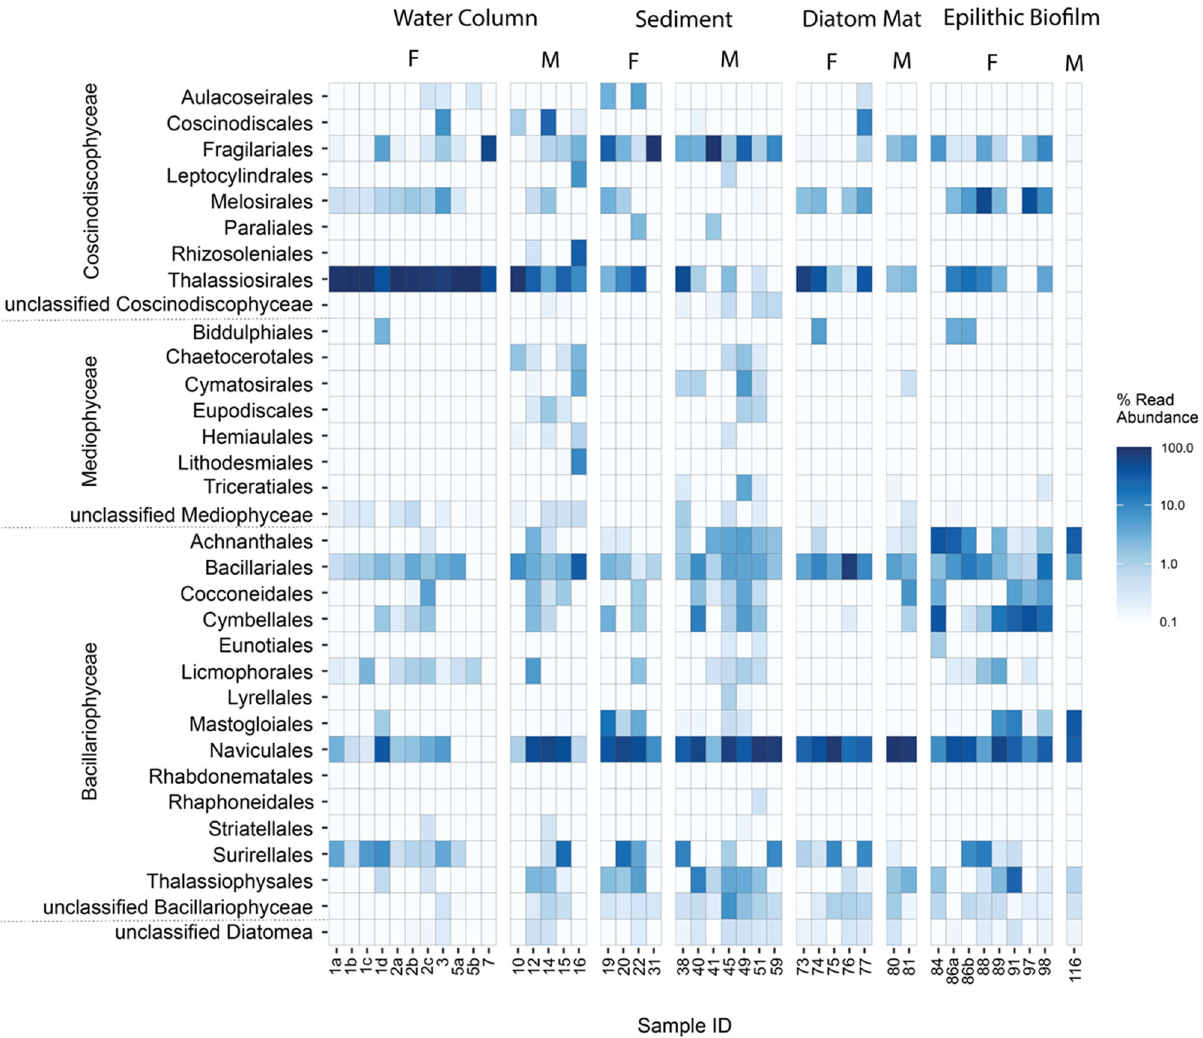
Fig. 6 Diatom community analysis. Heatmap of relative 18S rRNA gene sequence abundance at the level of diatom classes and orders for freshwater (F) and marine (M) water column, sediment, diatom mat, and epilithic bio fi lm samples. Relative sequence abundance scales from white (<0.15%) to dark blue (100%). Sample IDs are given in Supplementary Tab. 1 (Supplementary Data